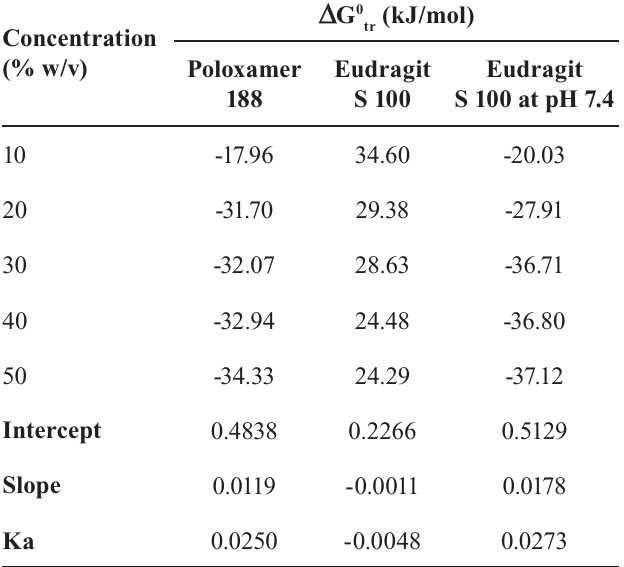
TABLE II - Gibbs free energy values and apparent stability constants (Ka) of Ketoprofen - Poloxamer 188 and Eudragit